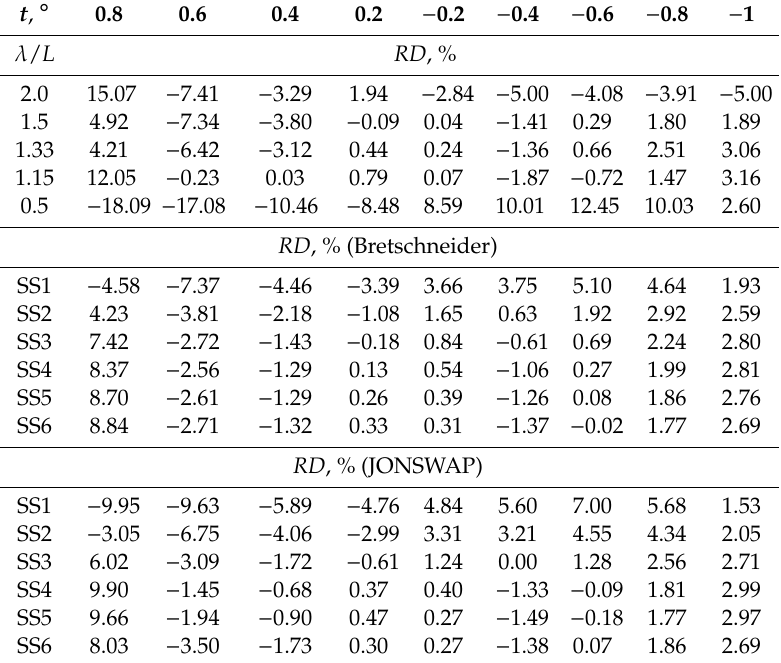
Table 7. Influence of trim on added resistance in regular and irregular